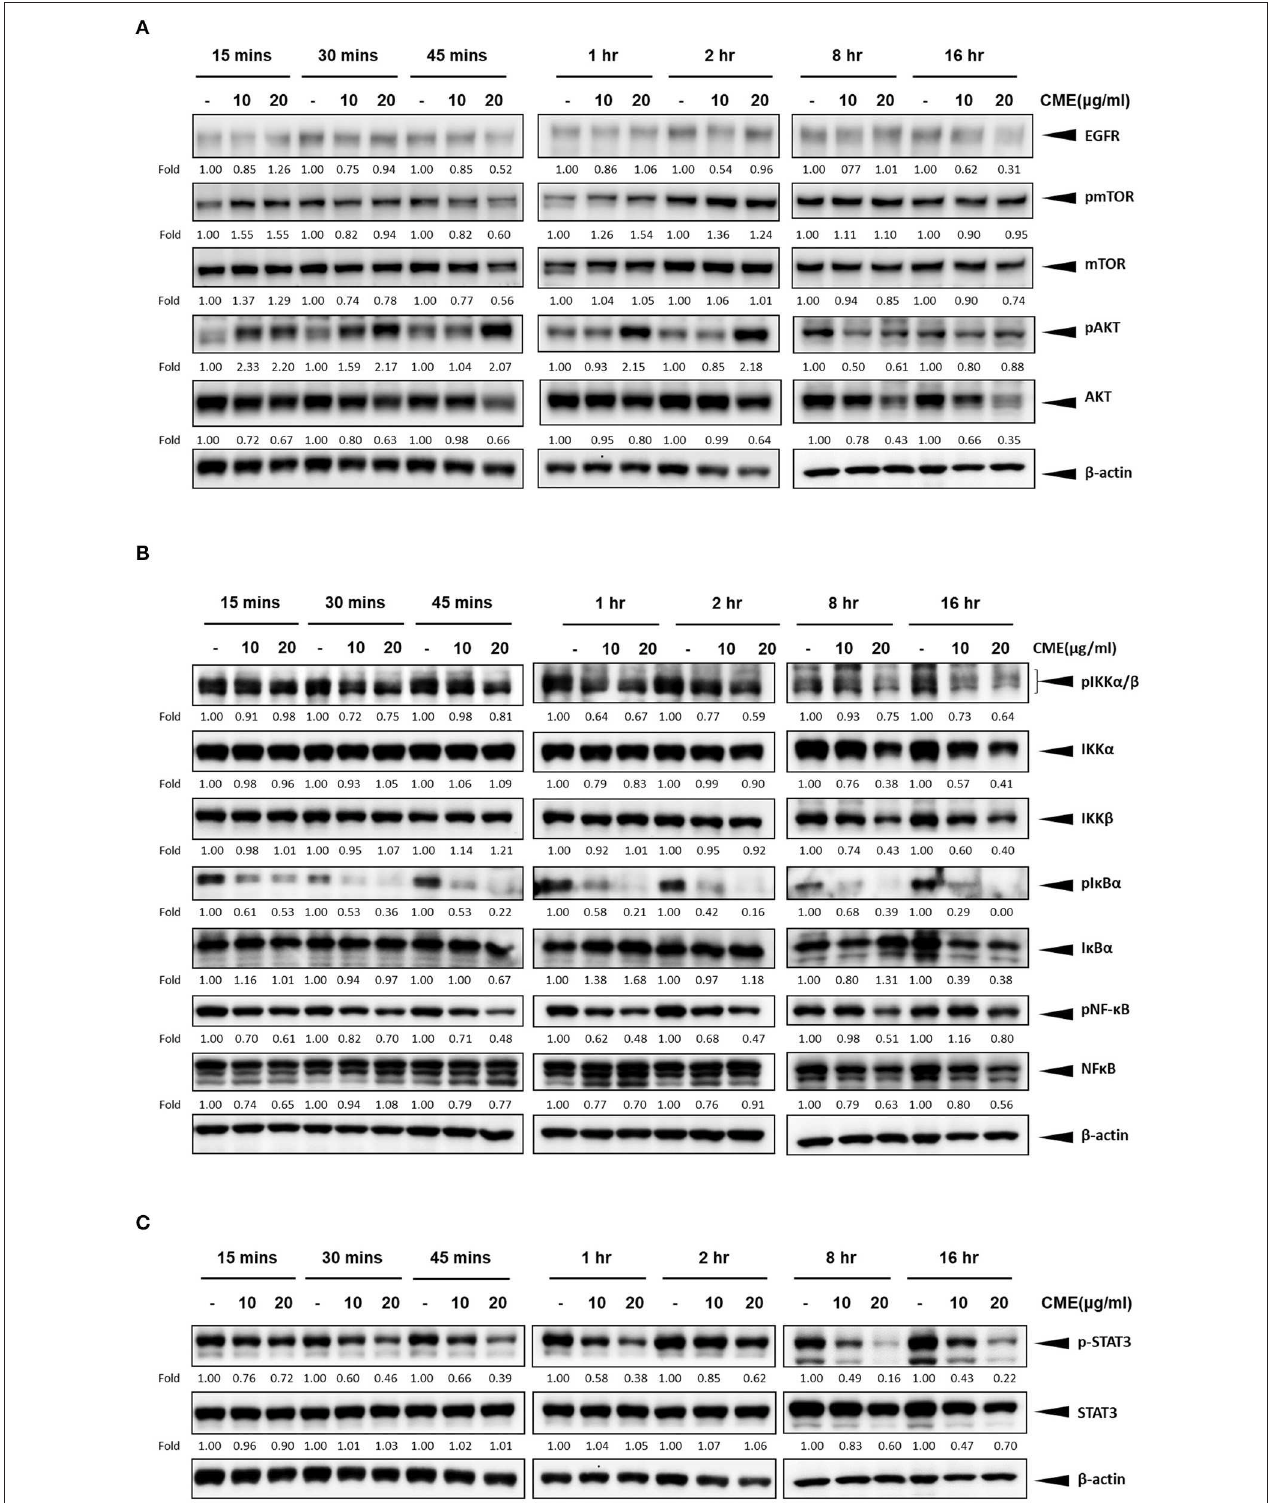
FIGURE 6 | CME suppressed NF- κ B, STAT3, and PI3K/AKT/mTOR signaling in MDA-MB-231 cells. MDA-MB-231 cells were treated with CME at 10 or 20 µ g/ml for the indicated time points, from 15min to 16h. Cell pellets were collected for Western blot analysis. The expression of key proteins in the (A) PI3K/AKT/mTOR, (B) NF- κ B, and (C) STAT3 signaling pathways. β -Actin was probed as a loading control. Protein expression is indicated, as fold of control. Three independent experiments were conducted and representative blots are shown.